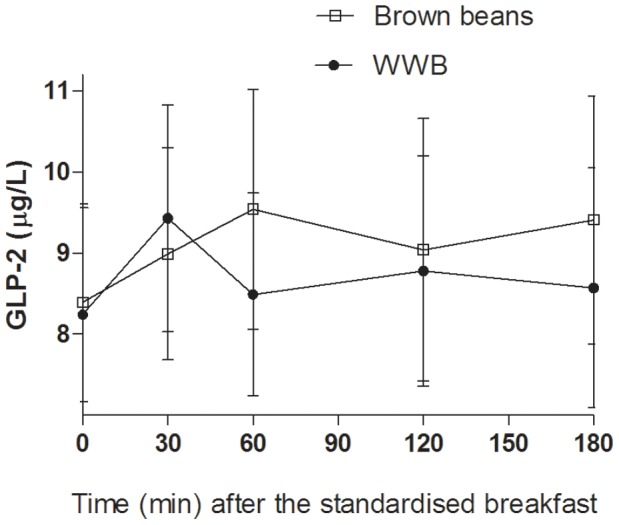
Concentrations of plasma GLP-2 fasting and after a standardized breakfast, consumed 11 hours after evening meals composed of brown beans or WWB.A tendency was found towards a meal*time interaction in the postprandial period after the standardized breakfast (p = 0.065, PROC MIXED in SAS release 9.2; SAS Institute Inc, Cary, NC), revealing a higher plasma GLP-2 in the later postprandial period when the subjects consumed brown beans as an evening meal compared with the WWB (60–180 min, p<0.05). n = 16 subjects.